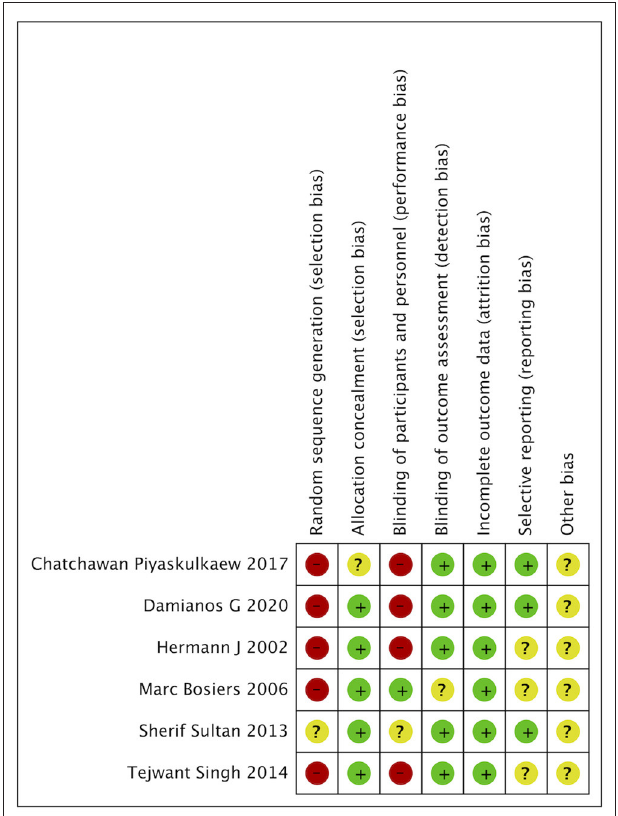
FIGURE 2 | Risk of bias summary. “ + ” refers to low risk of bias, “–” refers to high risk of bias, “?” refers to unclear risk of bias.